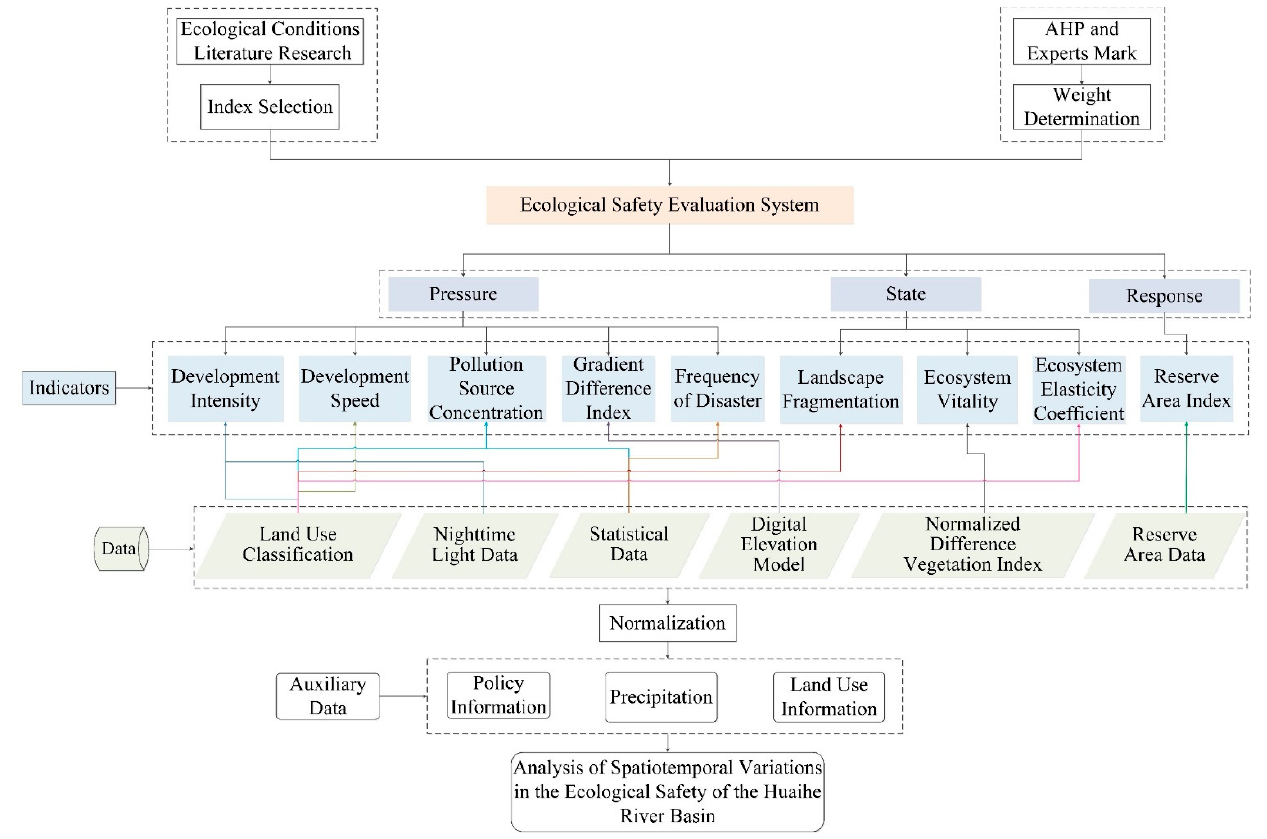
Figure 2. The flowchart of ES spatiotemporal original difference analysis for the HRB.